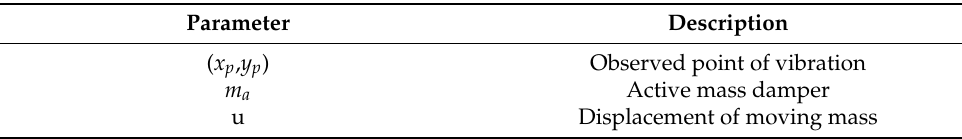
Figure 5. Frequency response function of the partially submerged plate (H = 0.3 m) controlled by multi-input multi-output (MIMO) modal-space negative acceleration feedback control (NAF), ( a ) magnitude and ( b ) phase. Table 4. Control